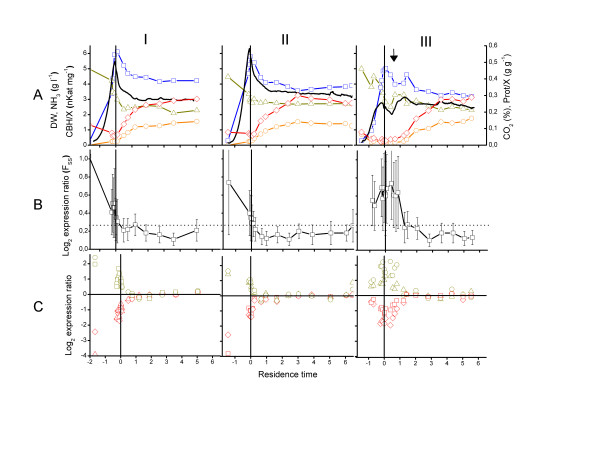
Evaluation of marker gene expression stability during chemostat cultures with Trihoderma reesei RutC30. A. Dry weight (blue squares), off gas CO2 concentration (black line), protein concentration (g g-1 DW) (red diamonds) and specific cellobiohydrolase activity (nkat g-1 DW) (orange circles) and ammonium concentration (green triangles) in chemostat cultures I – III (D = 0.03 h-1). In culture III arrow indicates the addition of trace mineral solution. B. Average fold-change of expression from predicted steady state of 30 marker genes (FSS). Error bars indicate the average deviation in Fss between the different marker genes. C. Expression ratios of genes showing the highest variation between batch and continuous phase (increasing expression, red symbols cbh1, egl1) and (decreasing expression, green symbols gpd1, hsp70). Residence time 0 indicates the start of the continuous growth phase. Expression levels as log2 expression ratios from the Fma predicted steady state expression level.